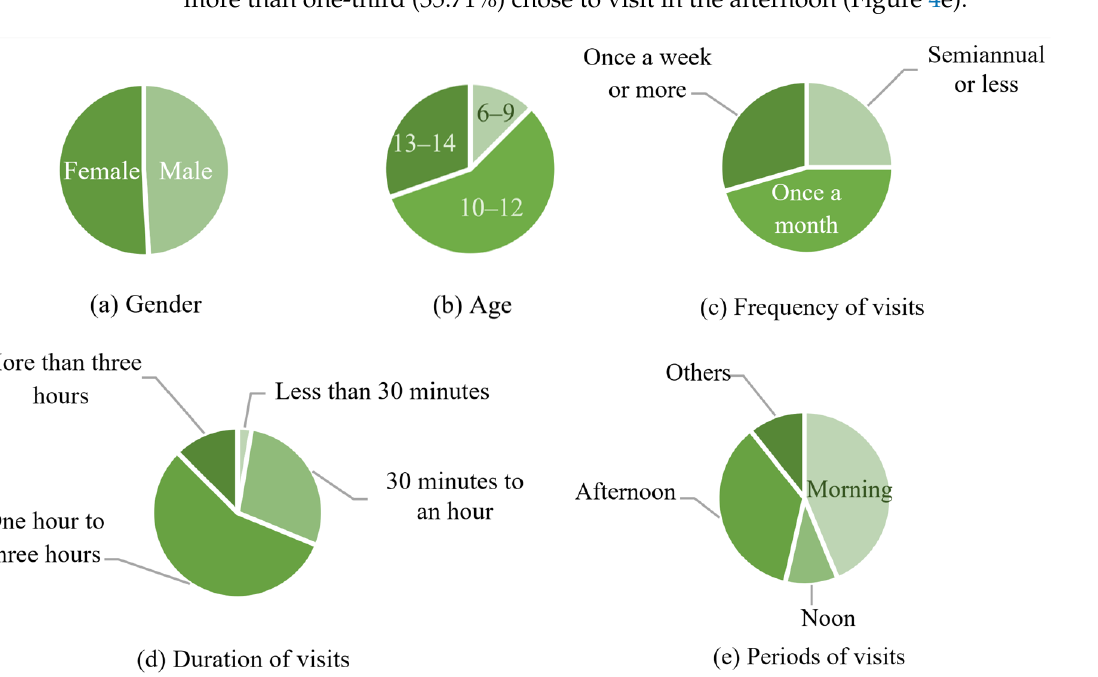
Figure 5. Description of surveyed children’s perceived preferences in the urban forest park. ( a ) Favorite color; ( b ) preference of color combination; ( c ) sensation that concerned them the most; and ( d ) sensation that concerned them the least. Items ( a , c , d ) were set as single-choice questions, while item ( b ) was set as a multiple-choice question.